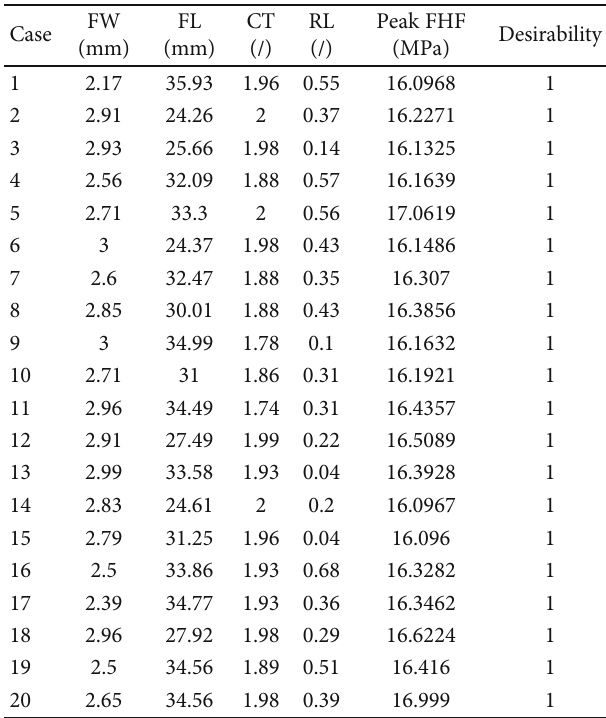
Table 6: The optimal solutions to obtain the maximum frost heaving force considering the four